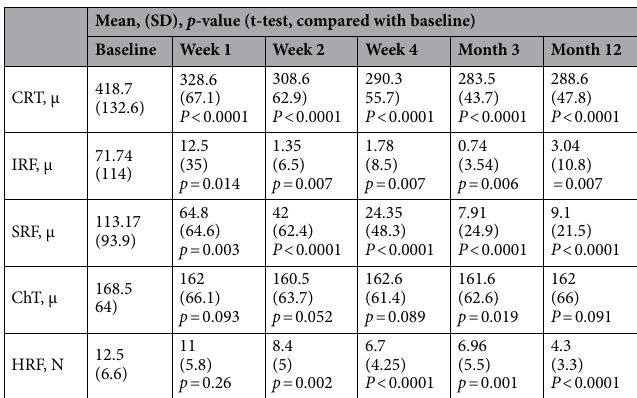
Table 2. SD-OCT based short- and long-term structural improvement. CRT central retinal thickness, IRF maximum height of intraretinal fluid, SRF maximum height of central subretinal fluid, Cht central point choroidal thickness, HRF hyperreflective foci at central 1 mm diameter.